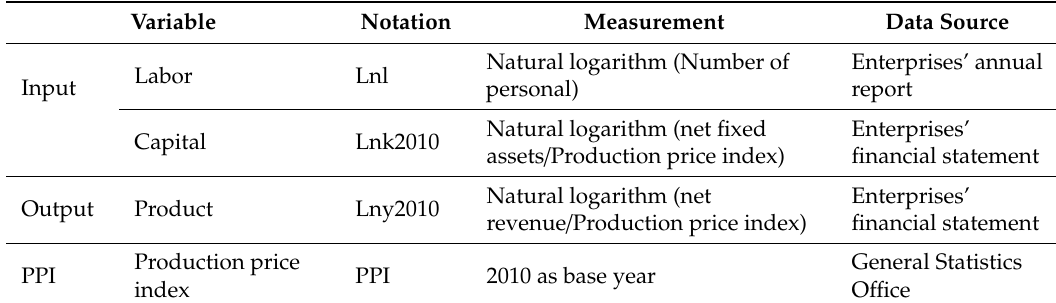
Table 1. The measurements of the variables.